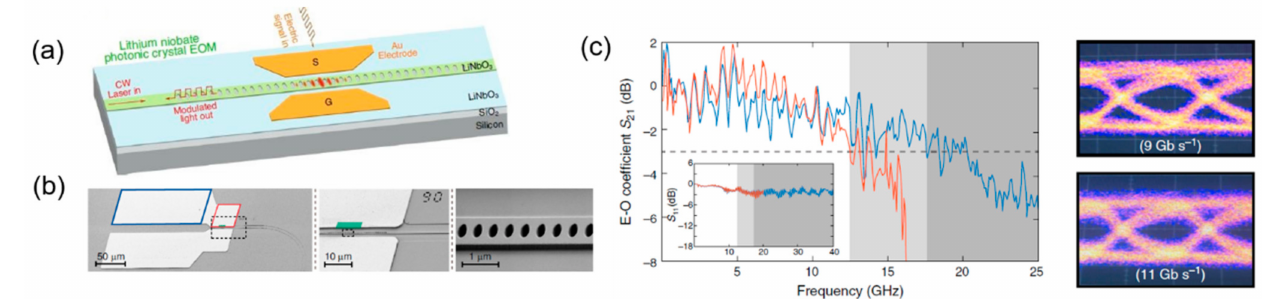
Figure 9. Silicon-based lithium niobate (LN) photonic crystal modulator ( a ) Schematic of the designed modulator [52]. ( b ) SEM image of the detailed structure [52]. ( c ) The high-speed performance of the modulator: electro-optic bandwidth and eye diagram